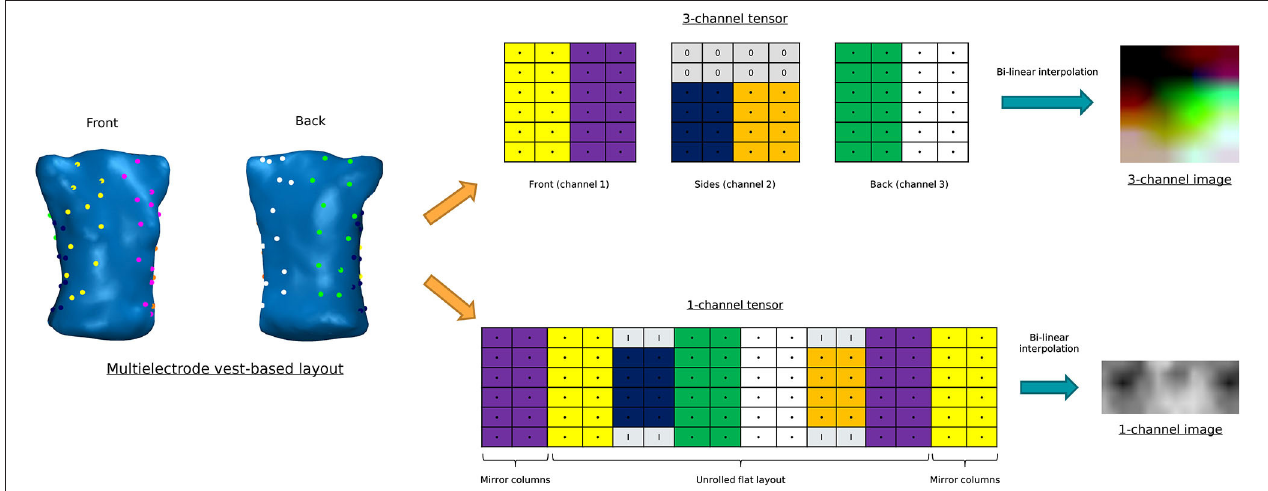
FIGURE 2 | Construction of the different tensor layouts. Above: 3-channel tensor. Below: 1-channel tensor.